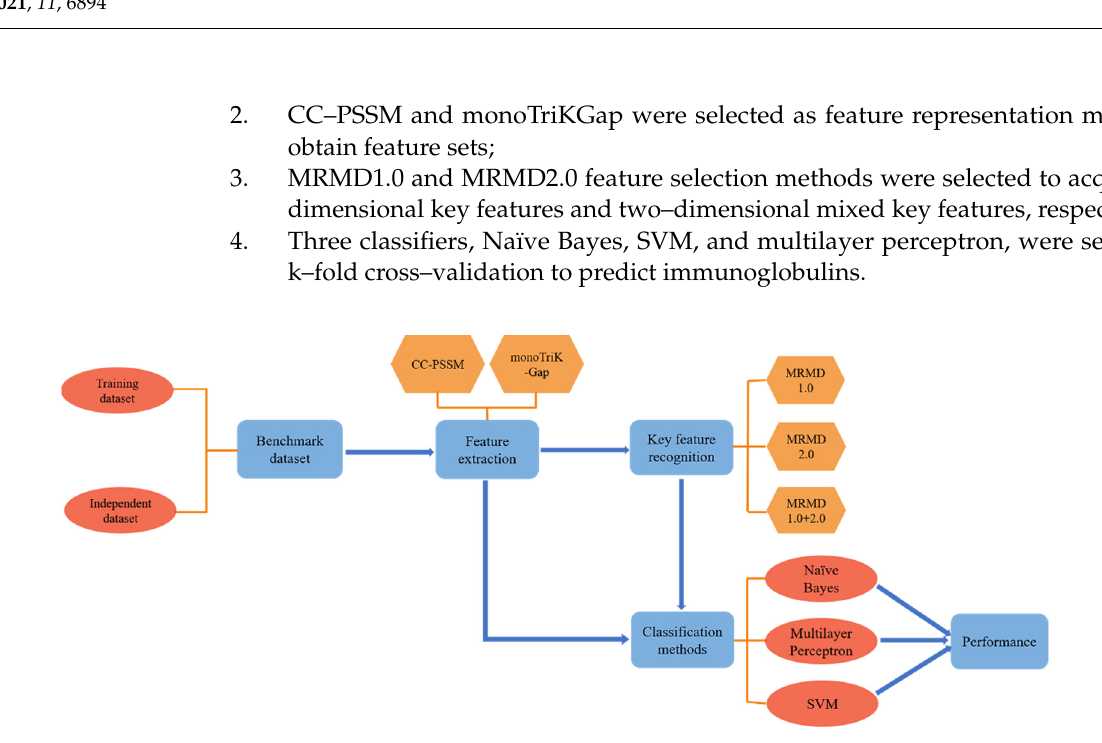
Figure 1. The overall framework of immunoglobulin prediction and key feature recognition. First, the dataset was established, and, next, the protein sequence was represented by CC–PSSM and monoTriKGap. Then, the work was divided into two parts: identifying key features and predicting and evaluating. In the above steps, MRMD1.0, MRMD2.0, and MRMD1.0+2.0 were used to obtain key features, and k–fold cross–validation was performed under Naïve Bayes, multilayer perceptron, and SVM classifiers ( k = 5 ).